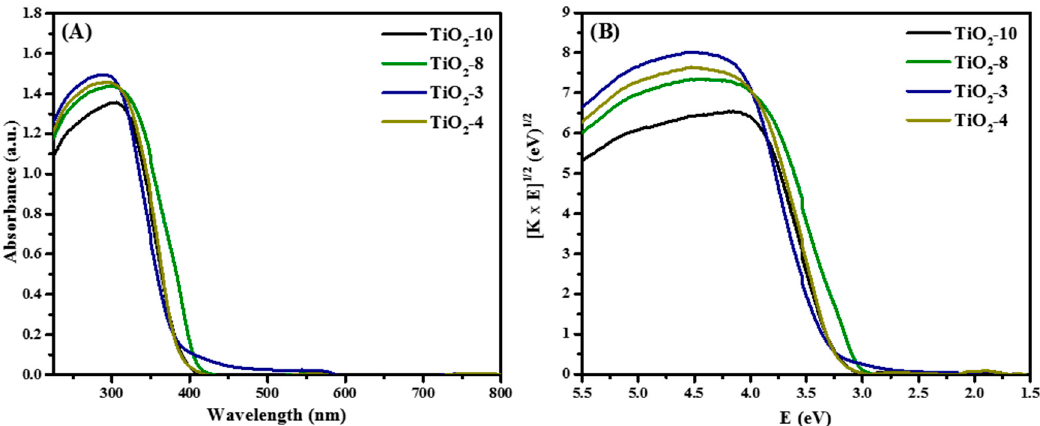
Figure 4. DRS of hard templated TiO 2 mesoporous materials as function of cycle and titanium precursor ( A ) Absorbance plot and ( B ) Tauc plot.